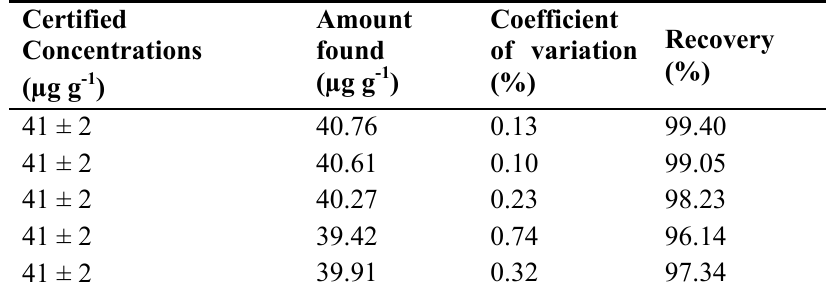
Table 3. Domoic acid concentrations in certified referent material ASP-Mus-c, n =